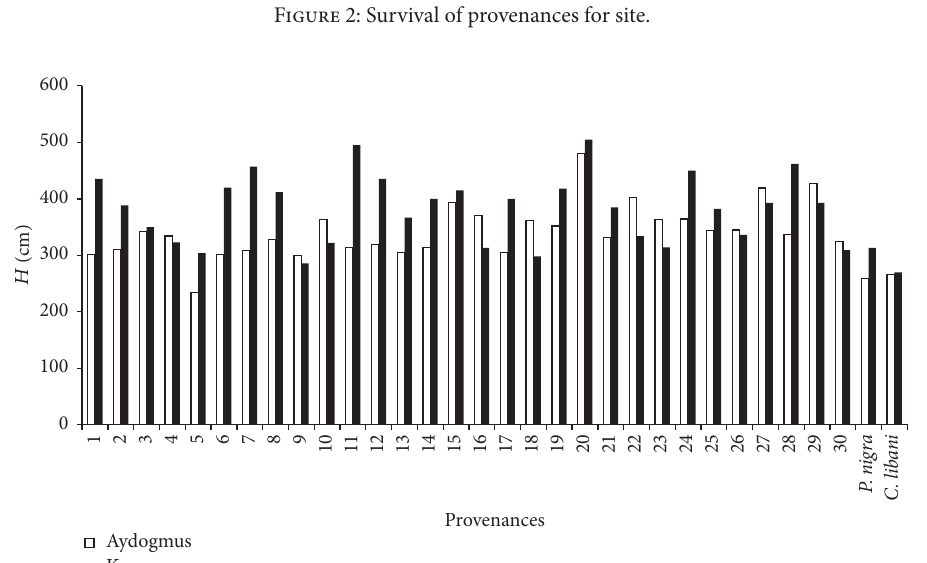
Figure 2: Survival of provenances for site.